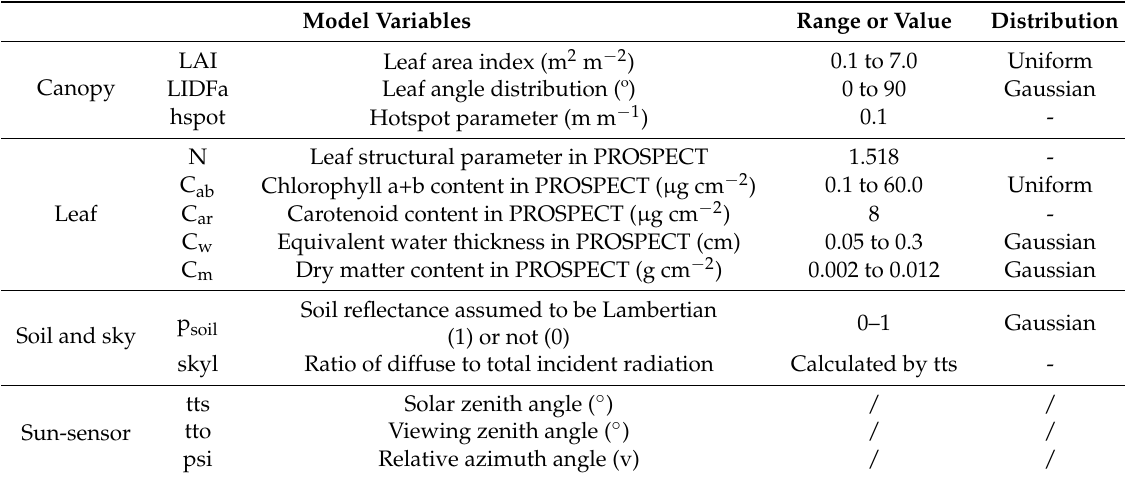
Table 3. Range and distribution of the input variables used to establish the synthetic corn canopy reflectance database in the lookup